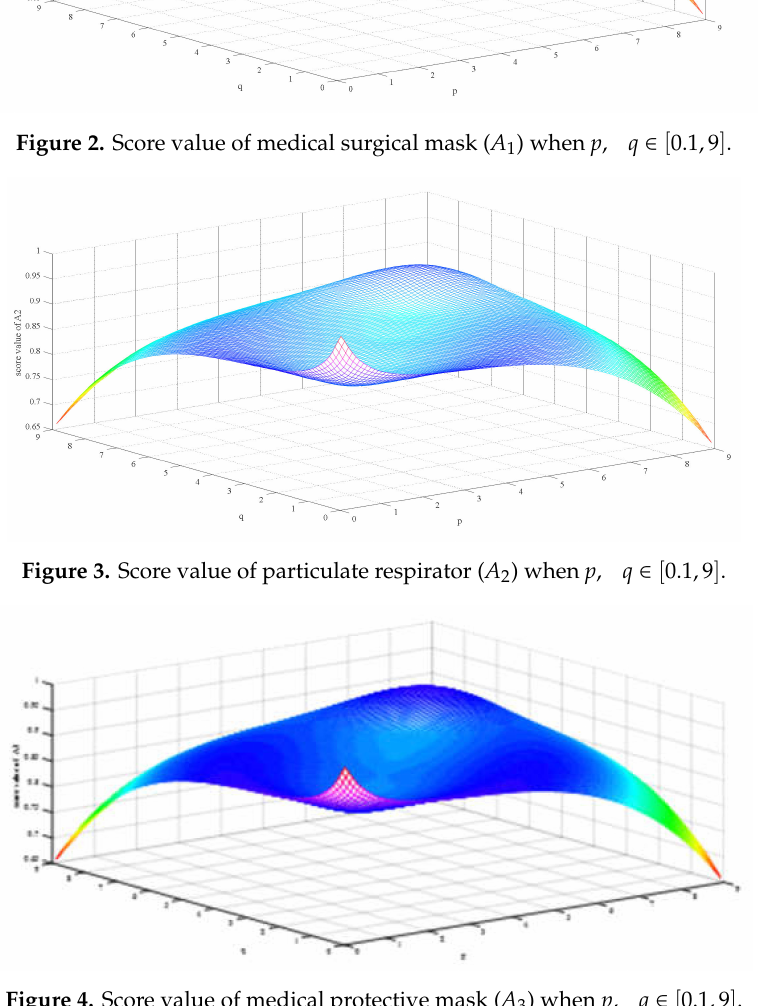
Figure 4. Score value of medical protective mask ( A 3 ) when p , q ∈ [ 0.1,9 ]